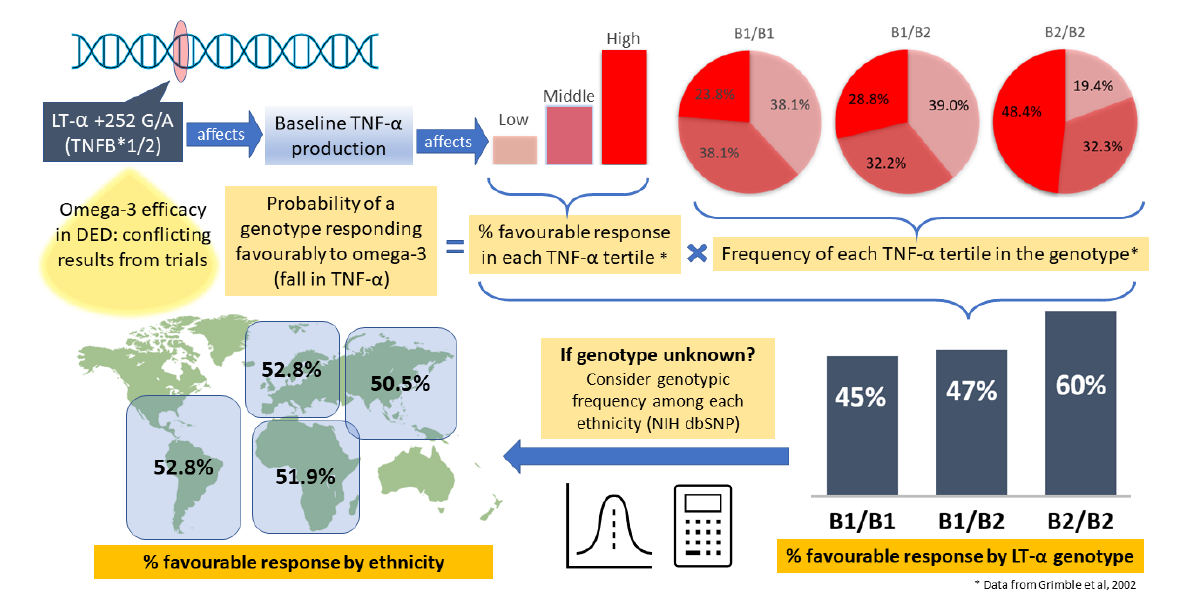
Figure 2. Polymorphisms in lymphotoxin-alpha may prognosticate response to omega-3 supplementation. Data marked with an * is reproduced from Grimble et al., 2002 [95].